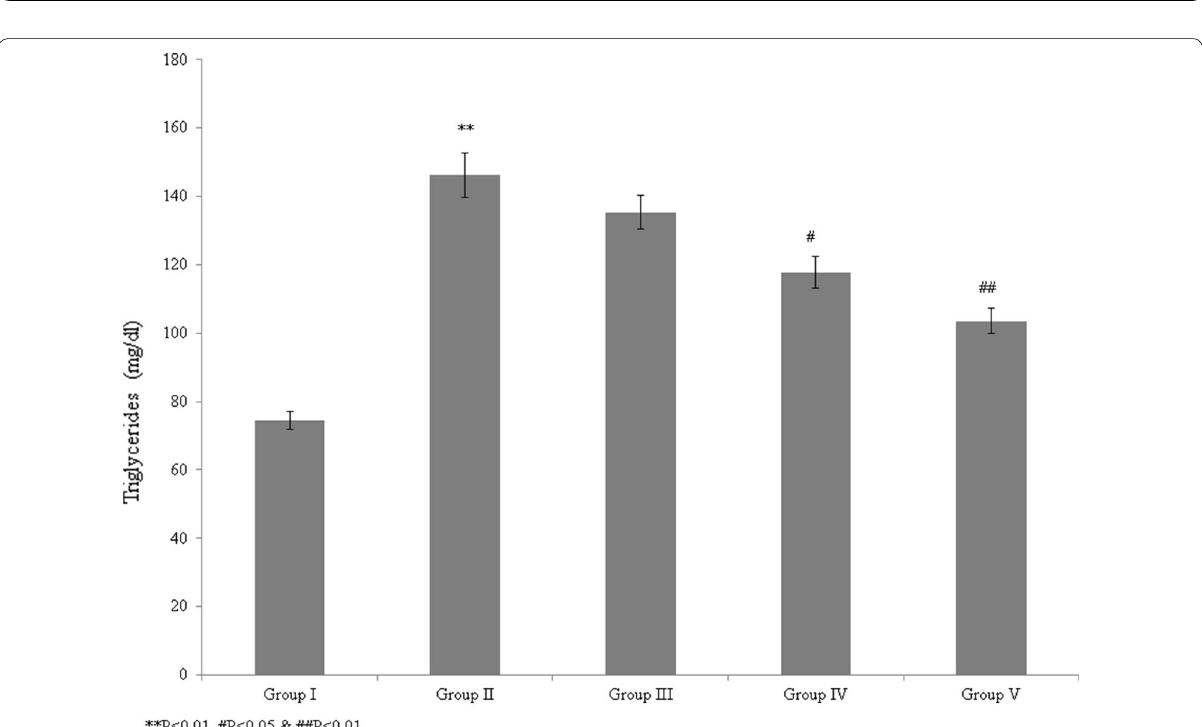
Fig. 3 The protective effect of a T. portulacastrum extract on triglyceride levels (mg/dL) in normal diabetic rats. ** P < 0.01 vs. sham; # P < 0.05 and ## P < 0.01 vs. control.